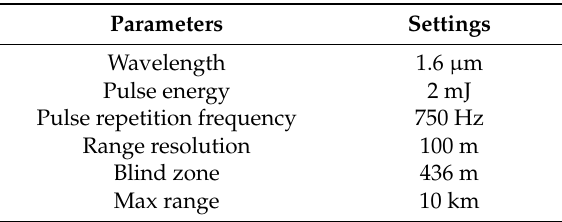
Table 1. Specifications of the Doppler lidar.